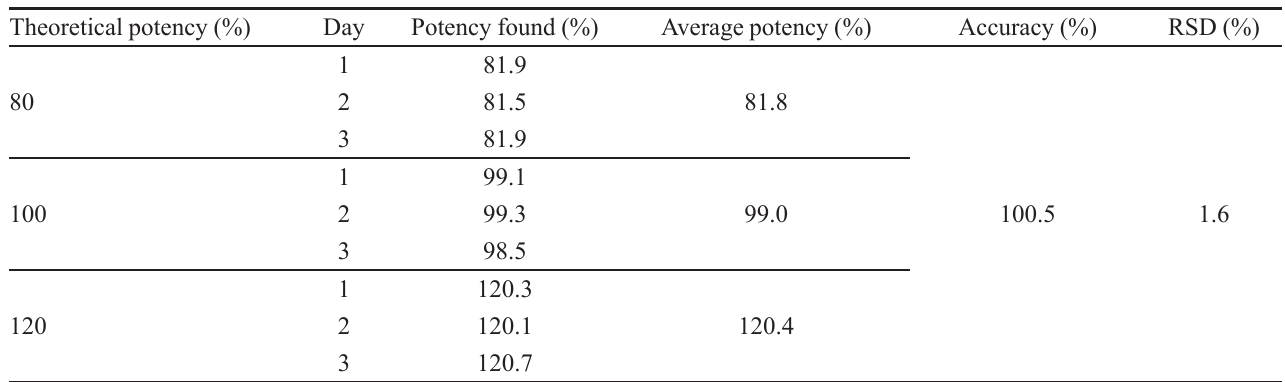
TABLE V - Accuracy of the proposed microbiological assay assessed by the analysis, in triplicate, of CFTX sample solutions diluted to 80%, 100% and 120% of the theoretical concentration Theoretical potency (%)